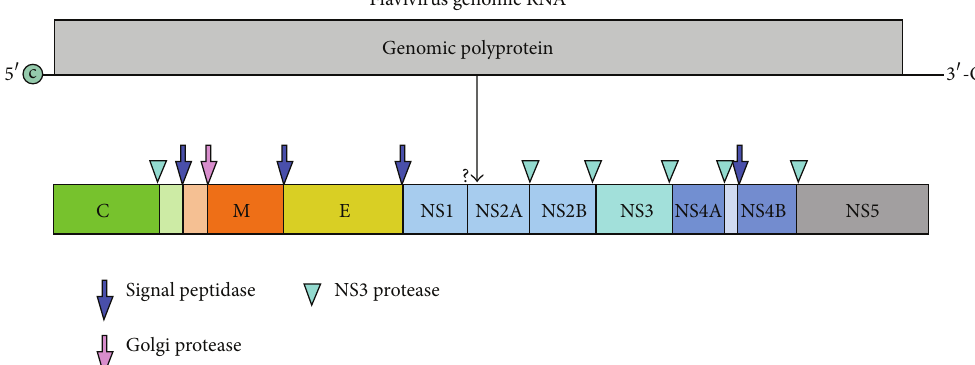
Figure 4: The 5 󸀠 terminus of the genome is capped and the polyprotein is expressed as a single polypeptide. The 3 󸀠 terminus is not polyadenylated but rather forms a loop structure. The locations of the nsP and structural proteins are switched with respect to the 5 󸀠 end of the RNA compared with the alphaviruses. It has been proposed that this switch occurred via recombination in an ancient precursor, thus retaining the structural glycoprotein folds. Capsid protein, preM, and E proteins are proteolytically processed as indicated by the enzymes shown by the arrows and arrowheads [ Virus DB: VBRC genome browser ]